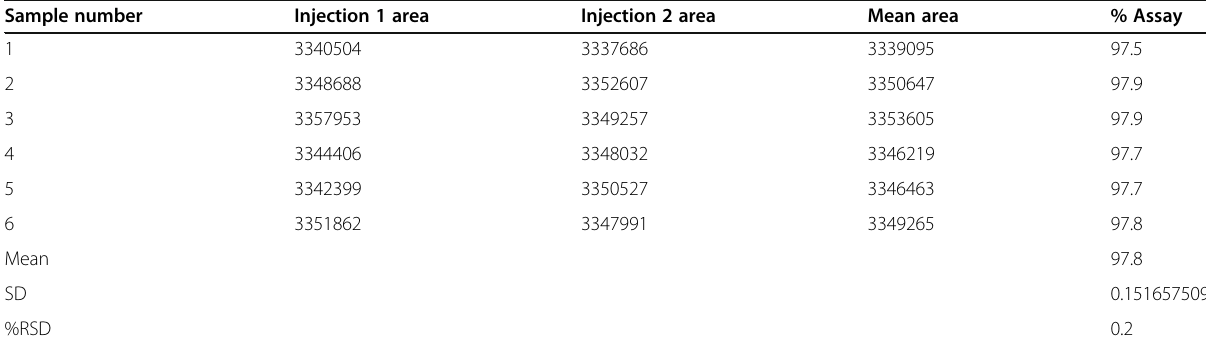
Table 4 Result of method precision Sample